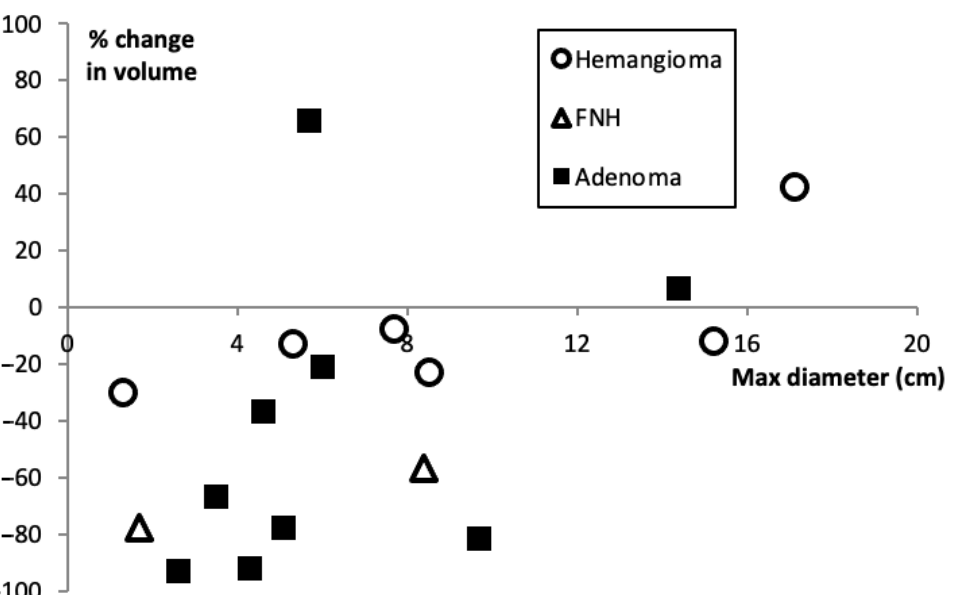
Figure 1. Percent change in lesion volume versus maximum initial diameter for bland transarterial embolization of hepatic hemangiomas, FNH, and adenomas. A negative percent change indicates that the lesion decreased in volume.